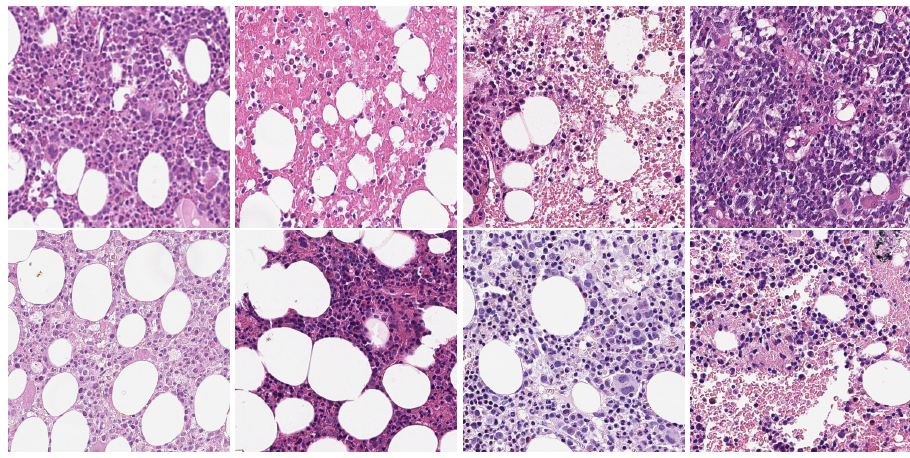
Figure 1. Example of chromatic issues on images belonging to the same